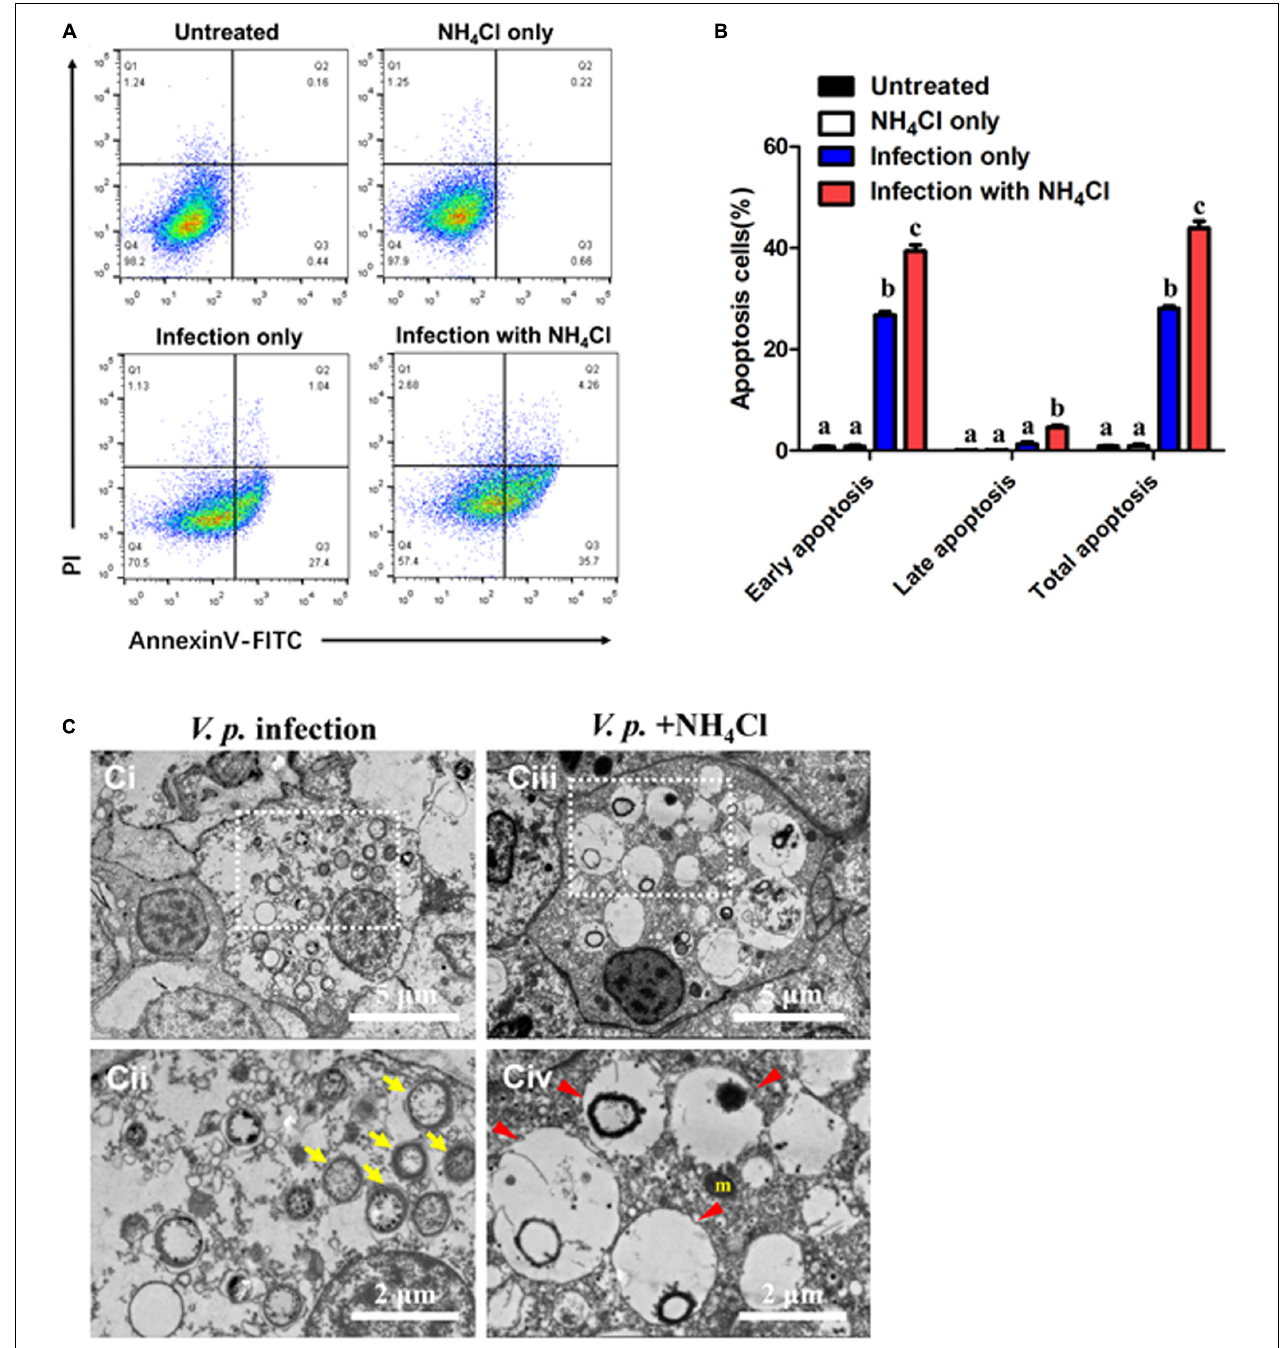
FIGURE 3 | Autophagy prevents premature apoptosis in hemocytes post-infection. (A) Representative dot-plot results in flow cytometry (FACS) for apoptosis (6 h) in hemocytes before (up panels) and after infection (down panels), with the autophagy blocker NH 4 Cl as an intervention. Q1: Cells stained positive with PI only (upper left quadrant) were necrotic/non-viable cells. Q2: Cells stained doubly positive by Annexin V-FITC and PI (top right quadrant) were cells undergoing late apoptosis/necrosis. Q3: On the lower right quadrant were cells stained positive by Annexin V only, representing cells undergoing early apoptosis. Q4: The lower left quadrant (PI and Annexin V negative cells) shows live cell population. (B) Statistical evaluation of the proportions of early apoptosis (Q3), late apoptosis (Q2) and total apoptosis (Q2 + Q3) cells by one-way ANOVA followed by Dunn’s post hoc test indicated by different alphabetical letters ( p < 0.05). Data are presented as mean ± SEM ( n = 4). (C) Ultrastructural morphology of hemocytes in transmission electron microscopy (TEM). (Ci,ii) Representative images of the hemocytes at 6 h-post-infection ( V.p . infection). (Cii) Magnified image of region indicated in panel (Ci) , showing global autophagic vacuoles in the cytosol (yellow arrow). (Ciii,iv) Representative image of the hemocytes exposed to autophagy inhibitor after infection ( V.p. + NH 4 Cl) for 6 h. (Civ) Higher magnification of region indicated in panel (Ciii) , with large vacuoles in the cytosol (red arrowhead). m, mitochondria.